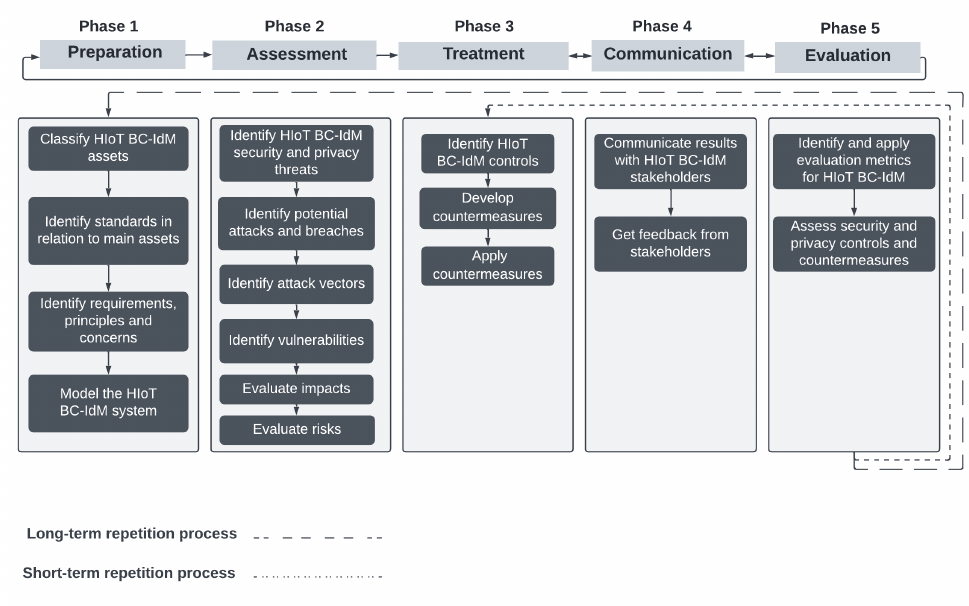
Figure 6. HIoT BC-IdM cybersecurity risk management